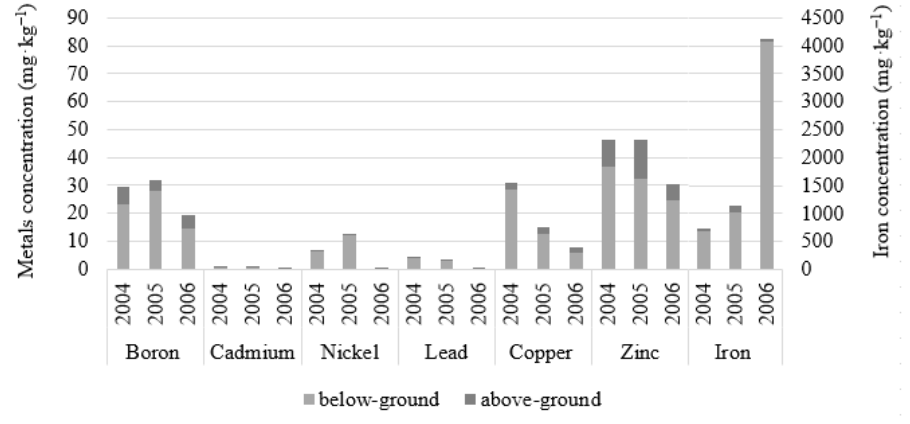
Figure 6. Heavy metal concentrations in below ‐ and above ‐ ground plant biomass.